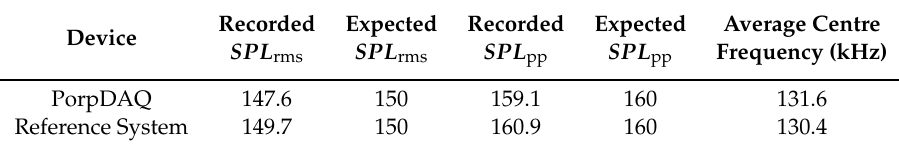
Table 2. Performance comparison between the reference system and the data acquisition